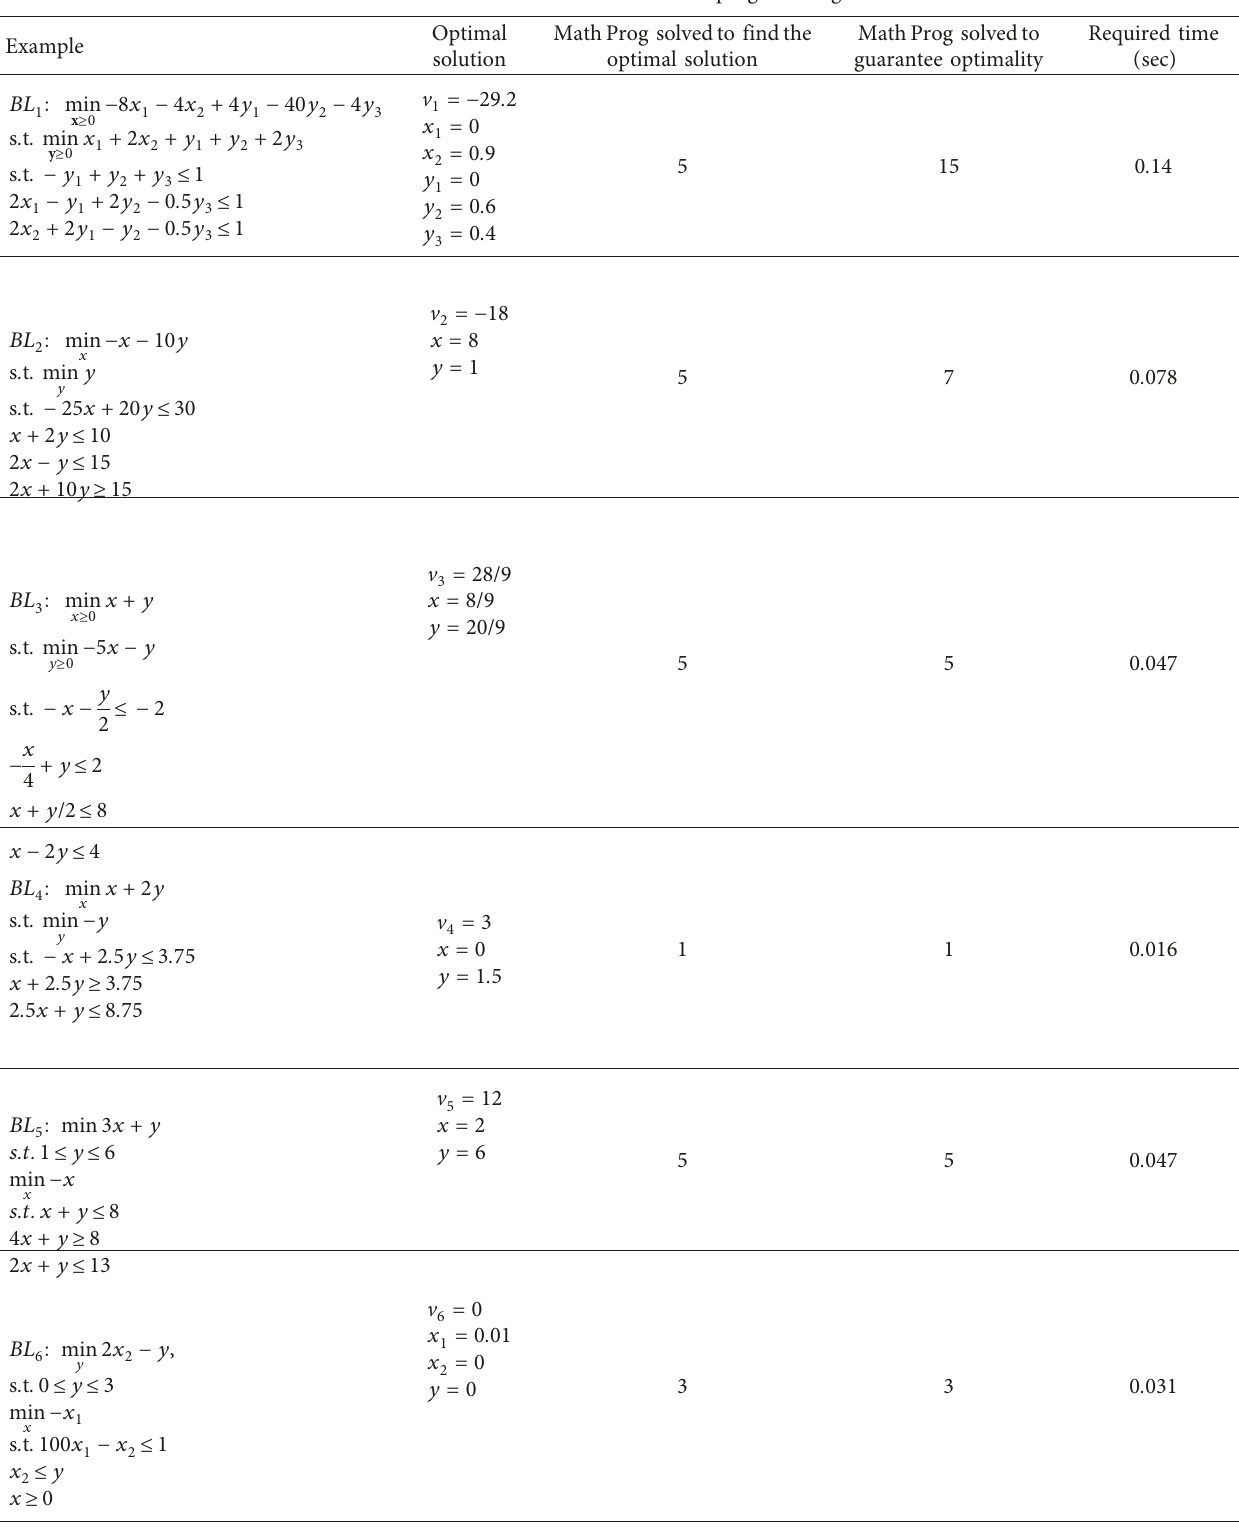
Table 2: Results in linear bi-level